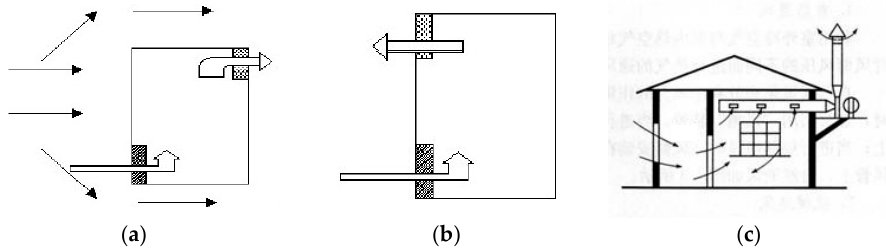
Figure 1. Ventilation models, ( a ) Natural ventilation by wind pressure; ( b ) Natural ventilation by thermal pressure; ( c ) Mechanical ventilation